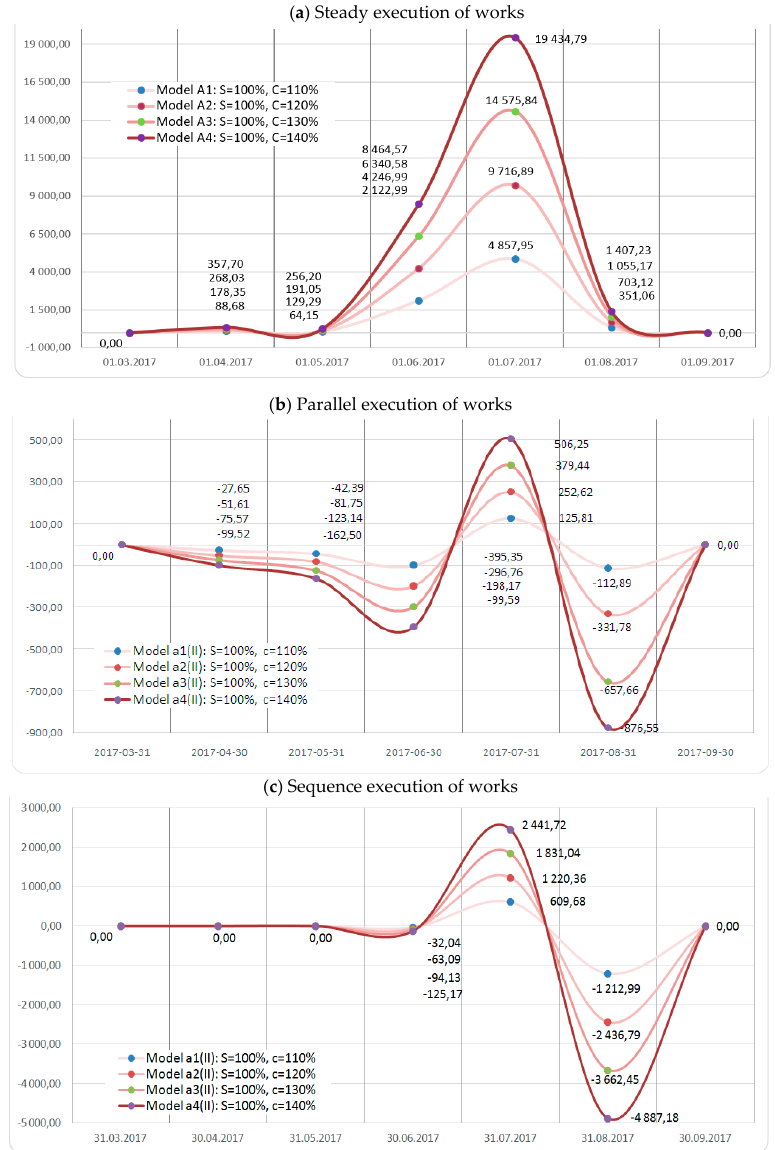
Figure 4. Monitoring indicator charts in the assumed financial liquidity due to the occurring time variances from the schedule (T/S) in models with a gradually increasing time variance-in the implementation methods according to (from above): steady, parallel, sequence execution of works. Source: [19].